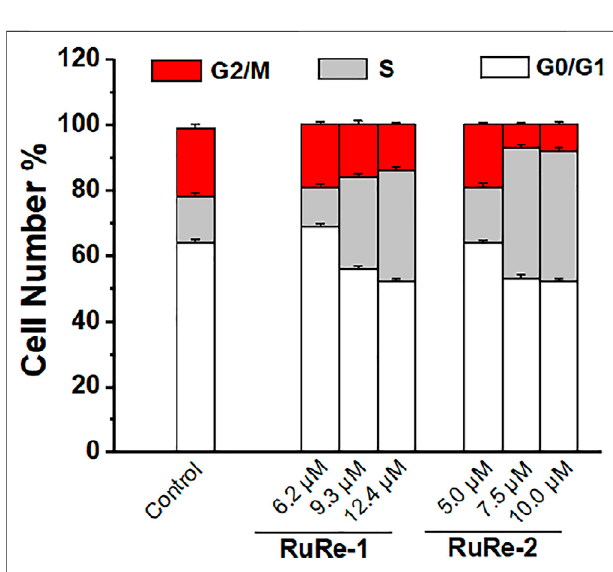
FIGURE 5 | Quantitative cell-cycle distribution data for HeLa cells after treatment with RuRe-1 and RuRe-2 for 24 h.